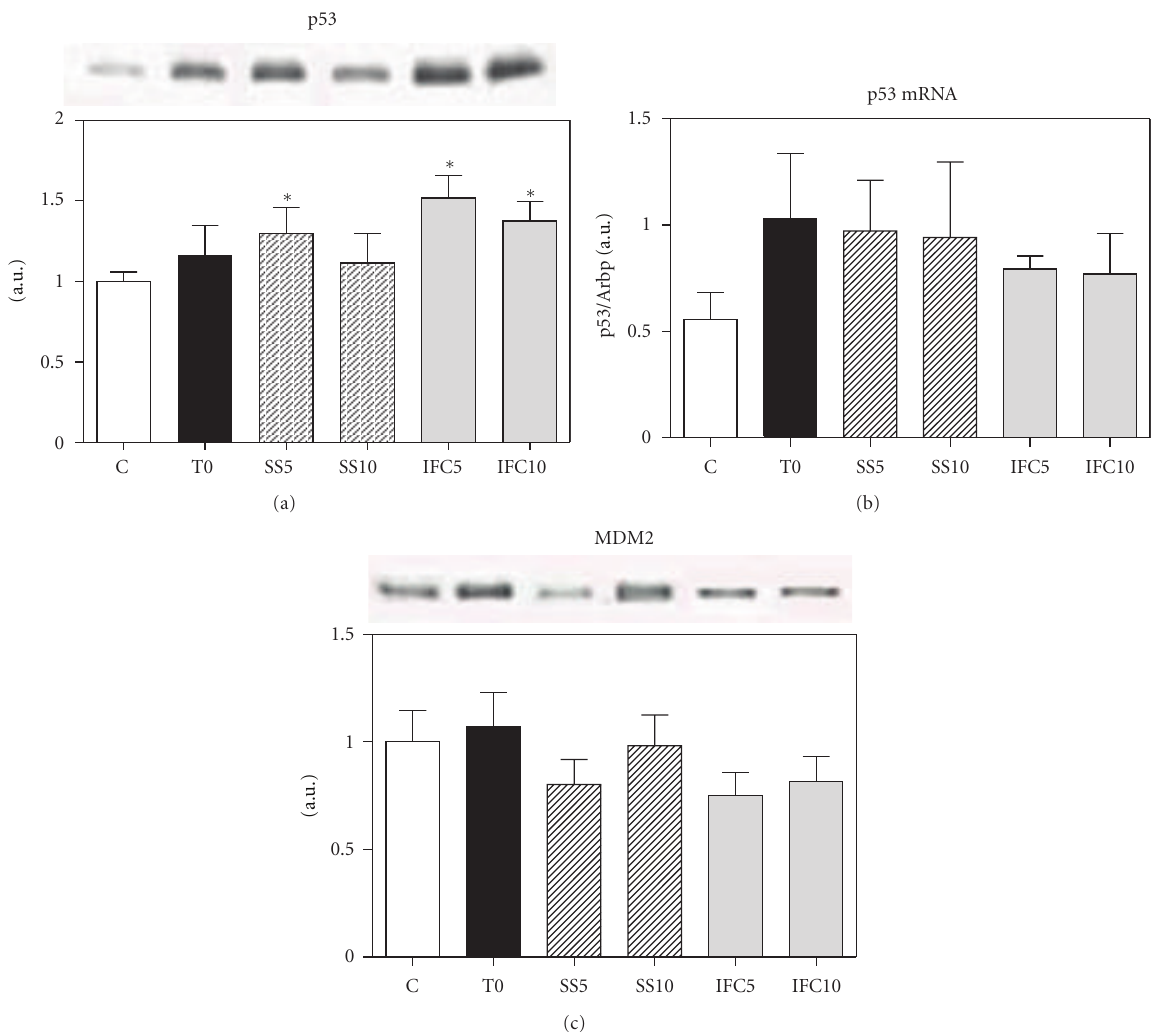
Figure 5: E ff ect of IFC305 treatment on p53 and MDM2 proteins expression in cirrhotic livers. (a) and (c) Expression of the indicated proteins from liver nuclear extracts was done by western blot analysis. A representative western blot image of each one is shown. The bar graph represents the densitometry analysis expressed as arbitrary units of the mean ± SEM from 3rats/group; values were normalized to β -actin immunodetection (image, Figure 1(a)). ∗ Statistical di ff erence ( P < 0 . 05) when compared to C group. # Statistical di ff erence ( P < 0 . 05) when compared to their respective experimental group SS5 or SS10. (b) E ff ect of IFC305 treatment on p53 mRNA expression in CCl 4 -induced cirrhosis in rats. RNA was isolated from liver and mRNA expression for Rb was analyzed by quantitative RT-PCR as described in Section 2. Arbitrary units were normalized with Arbp mRNA gene expression level. Data represent mean ± SEM from 3rats/group. ∗ Statistical di ff erence ( P < 0 . 05) when compared to C group. # Statistical di ff erence ( P < 0 . 05) when compared to their respective experimental group SS5 or